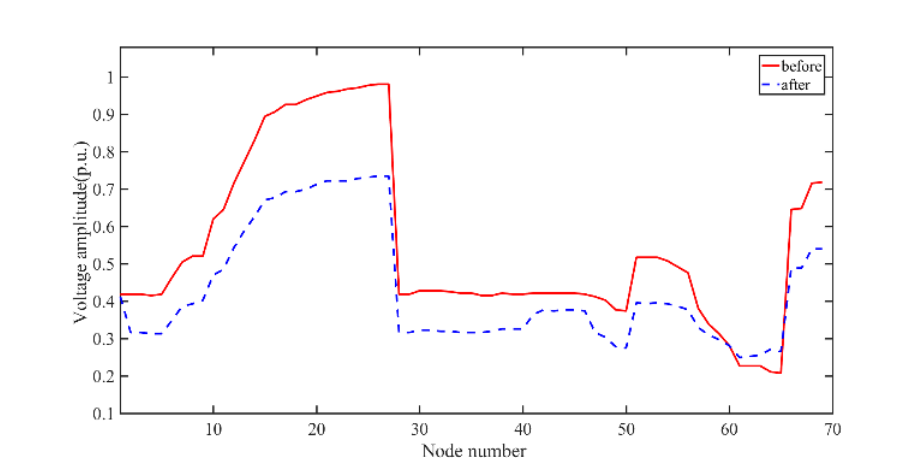
Fig. 6. Voltage distribution of the system before and after optimization at